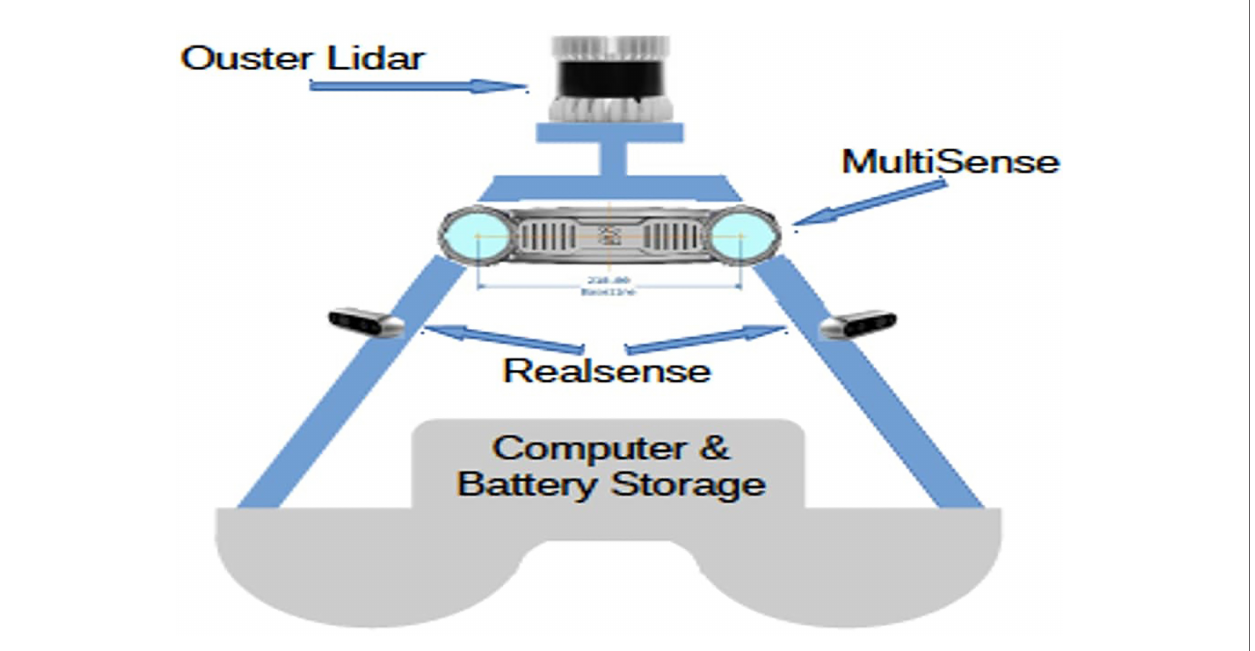
FIGURE 3 | Placement of the sensors on the platform and which is attached to the